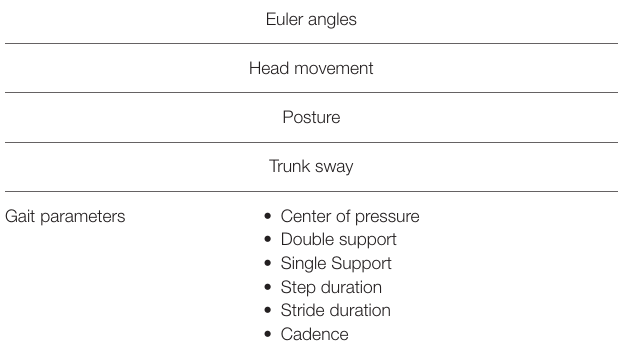
TABLE 1 | Motion metrics.